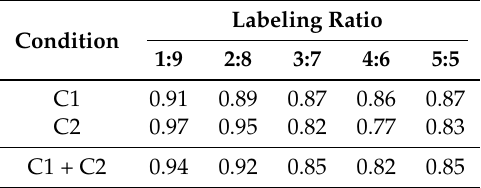
Table 5. The reliability (F1 score) of the predicted FPT corresponding to the labeling